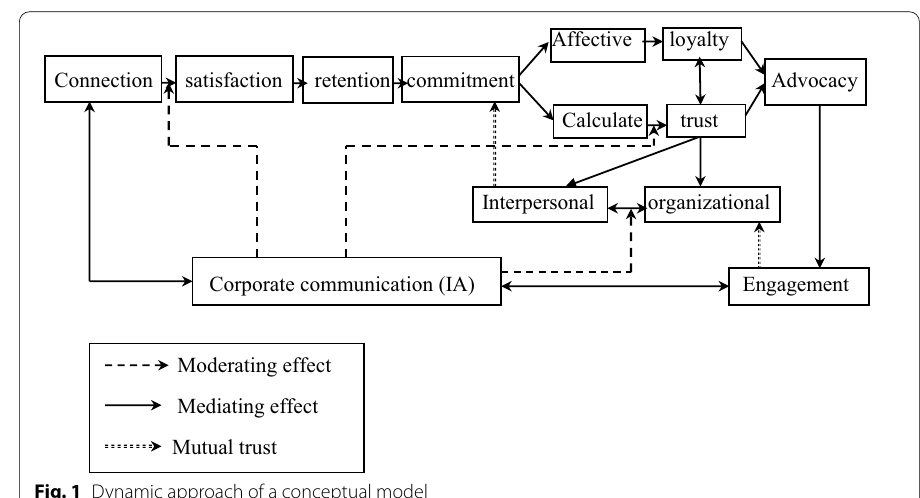
Fig. 1 Dynamic approach of a conceptual